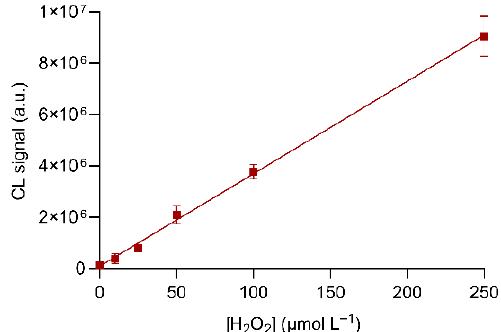
Figure 5. Calibration curve for hydrogen peroxide obtained in the optimized experimental conditions. The equation of the calibration curve is Y = (3.60 × 10 4 ± 2.0 × 10 3 )X + (9.4 × 10 4 ± 1.7 × 10 5 ), R 2 = 0.993, where Y is the CL signal and X is the concentration of hydrogen peroxide ( µ mol L − 1 ). Each value is the mean ± SD of six measures performed in three origami µPADs.